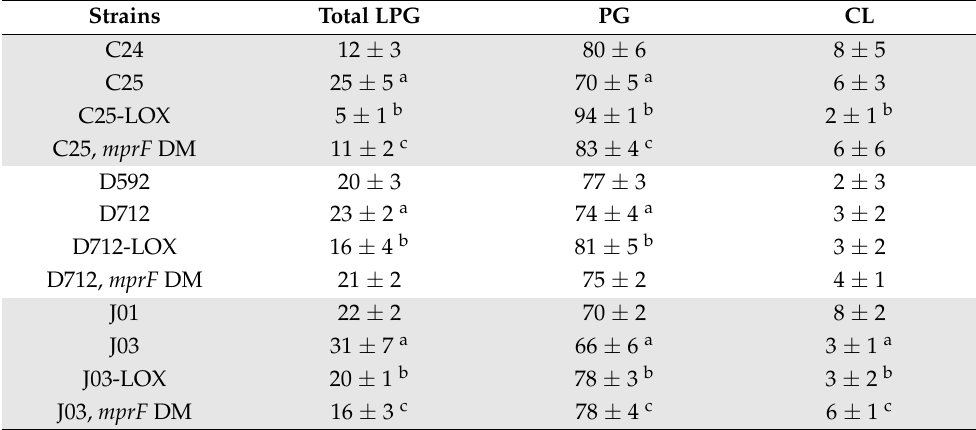
Table 2. Phospholipid composition (%) of LOX passaged strain vs. DAP-R/DAP-S. Strains